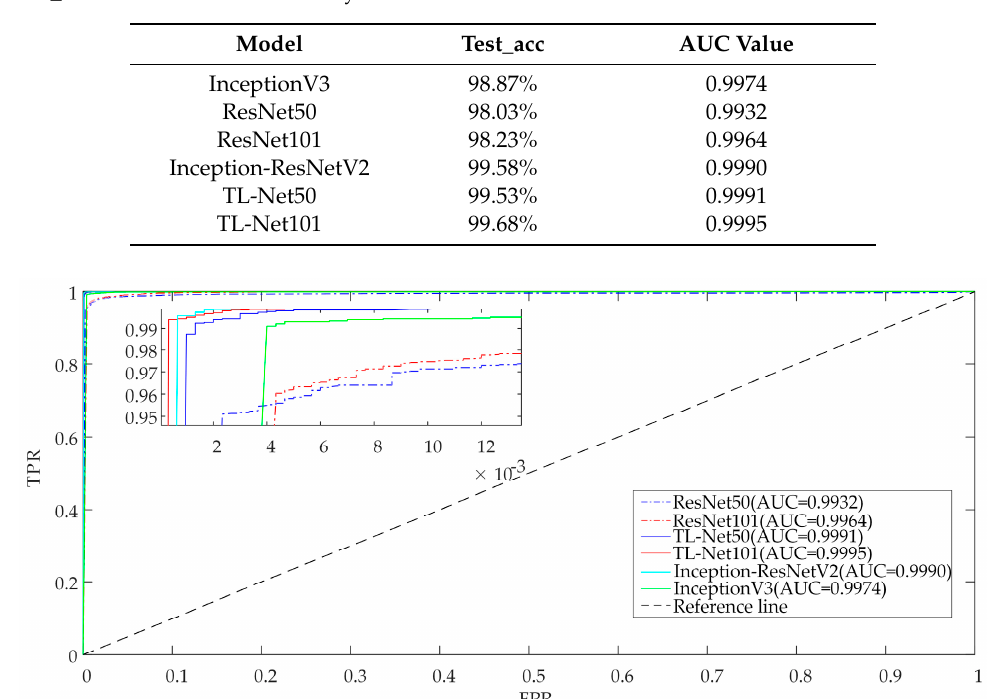
Figure 14. The ROC curves of ResNet50, ResNet101, TL-Net50, TL-Net101, Inception-ResNetV2, and